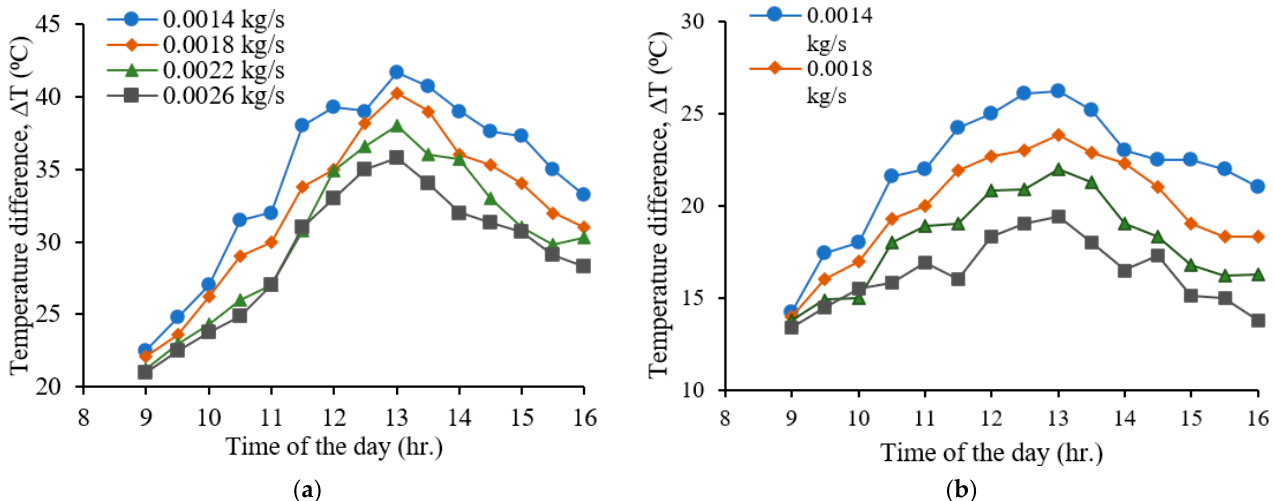
Figure 4. Outlet and inlet temperature difference at different time periods of the day ( a ) for air, ( b ) for water.